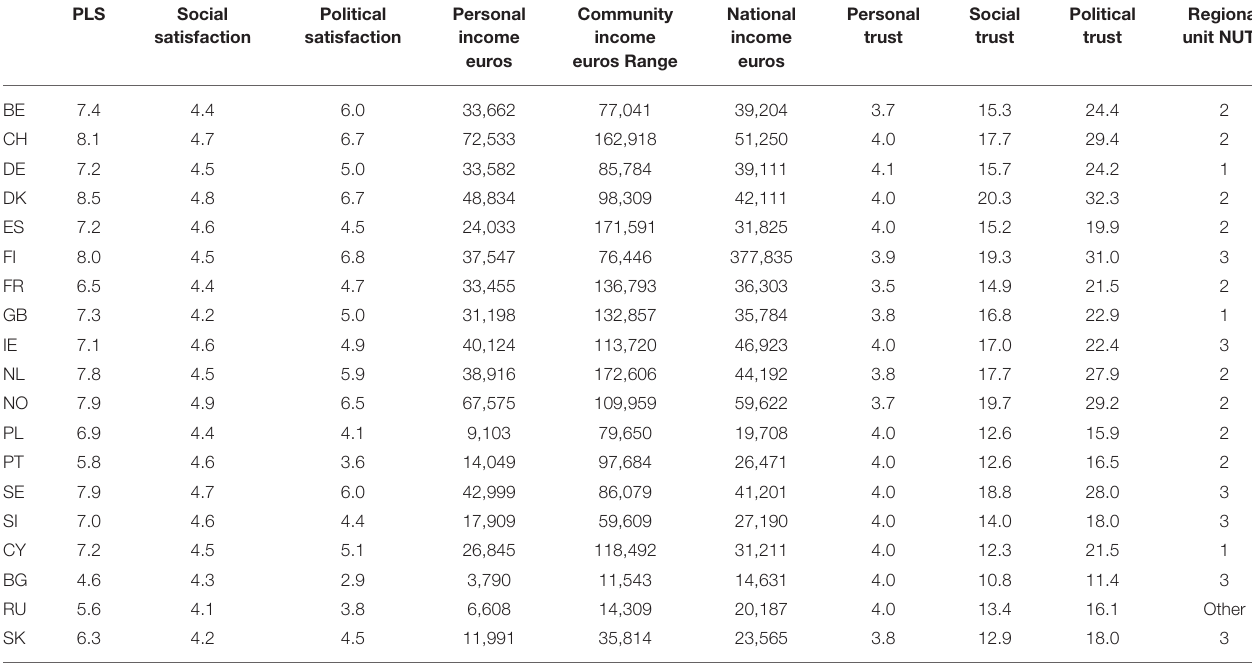
TABLE 1 | Weighted means/ranges of the primary variables of interest in the study by country. PLS Social